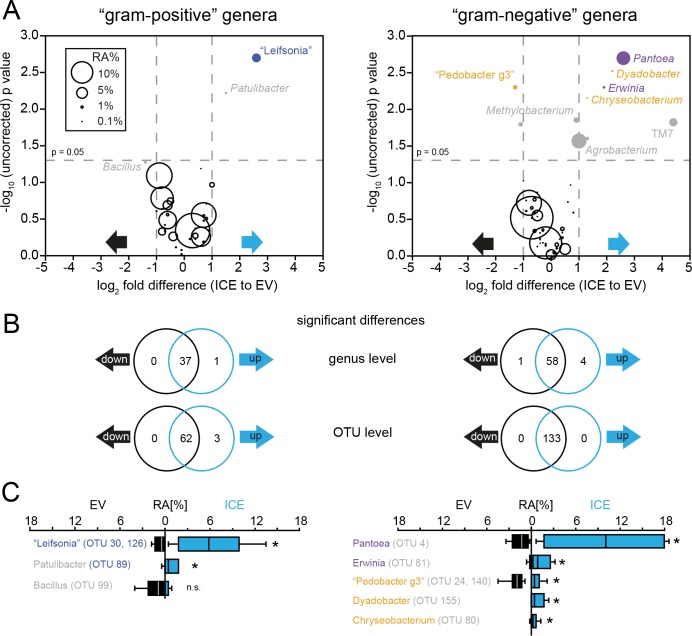
Genotype differences of the root-associated communities at genus and OTU level separated by gram type.(A) Volcano plot showing genera with differences in relative abundance among the genotypes on the x-axis (as log2 fold difference) and the -log10 (uncorrected) p value on the y-axis. Bubble size indicates relative abundance averaged from both genotypes. Genera which remained significant after correcting for a false discovery rate (FDR) of 10% are shown in color. Actinobacteria are shown in blue, Gammaproteobacteria in purple and Bacteroidetes in orange. (B) Venn diagrams showing significant differences at genus and at OTU-levels separated by gram type (up and down refers to an increase or decrease in the ICE genotype). (C) Relative abundances of the genera that showed significant differences among the genotypes. Patulibacter was only significant at OTU level. (non-parametric t-test with FDR correction of 10%).